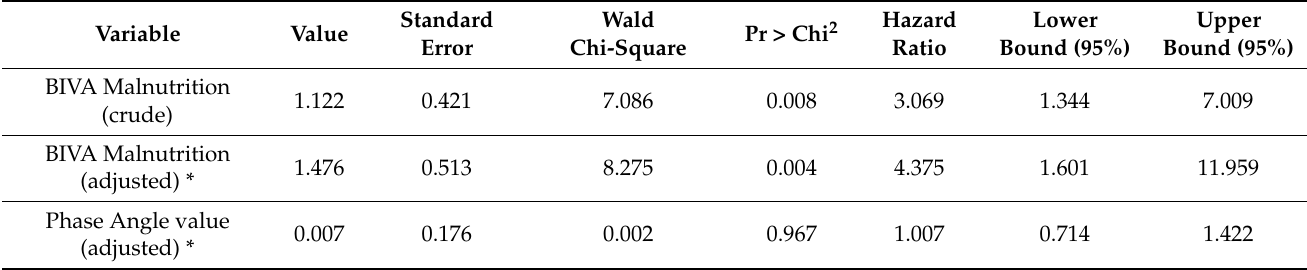
Table 4. Cox proportional hazard ratio for need of mechanical ventilation at 60 days. Crude and correct for covariates.